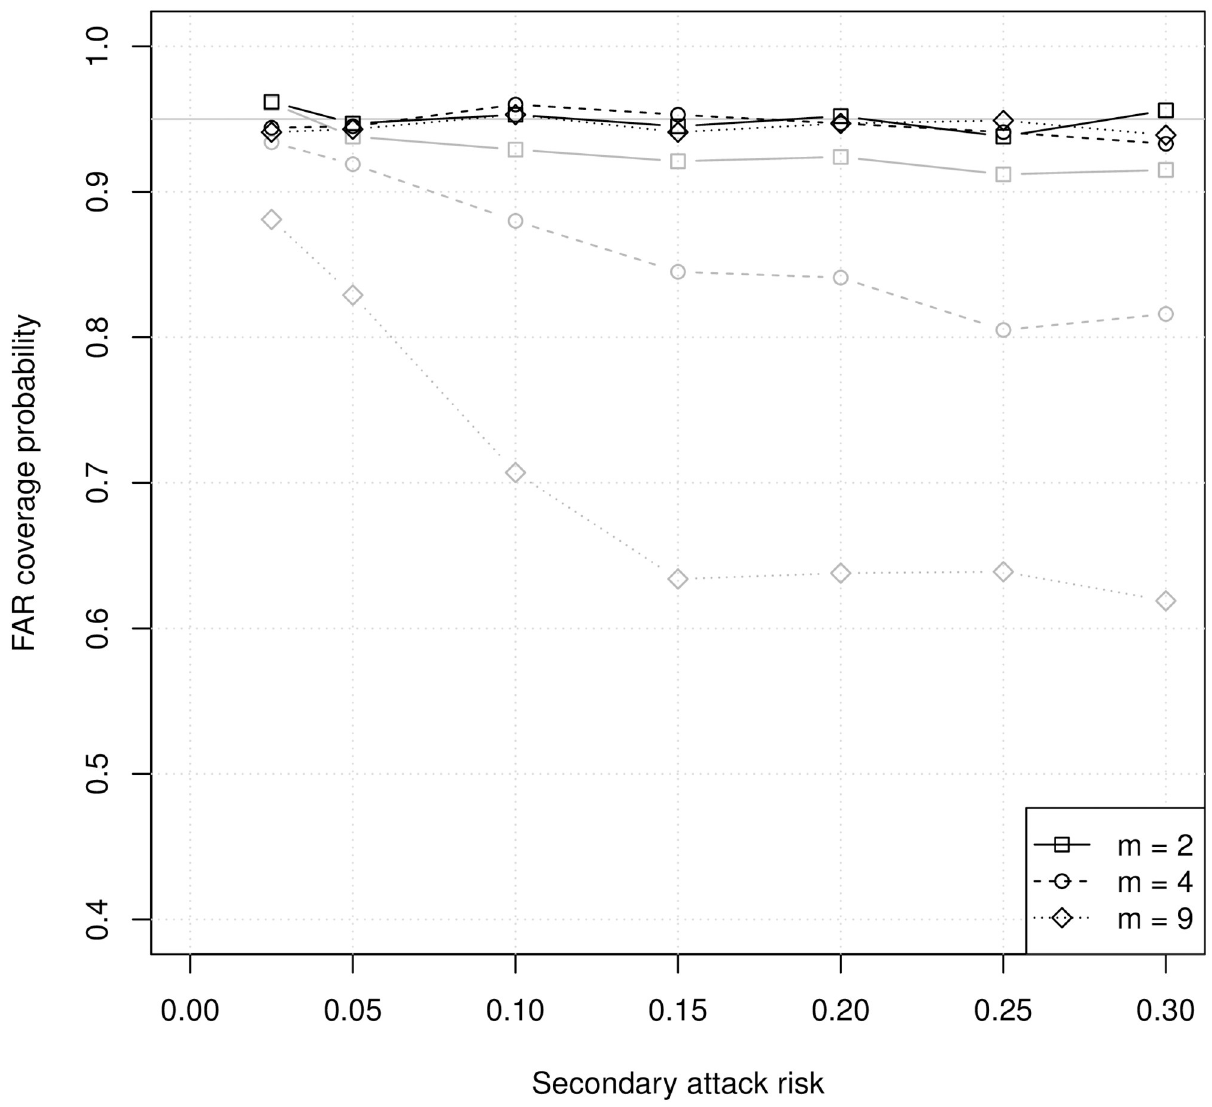
Fig 4. Coverage probabilities of binomial 95% confidence intervals for the household FAR with different numbers of susceptibles ( m ). Gray lines are coverage probabilities for unadjusted confidence intervals, and black lines are coverage probabilities for cluster-adjusted confidence intervals. Each symbol represents 1,000 simulations with 100 households